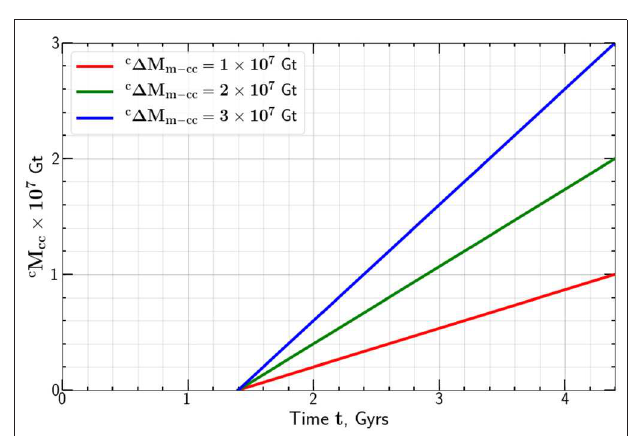
FIGURE 4 | Dependence of the mass of carbon added to the continental crust c M cc on time, t for t 0 = 1.4